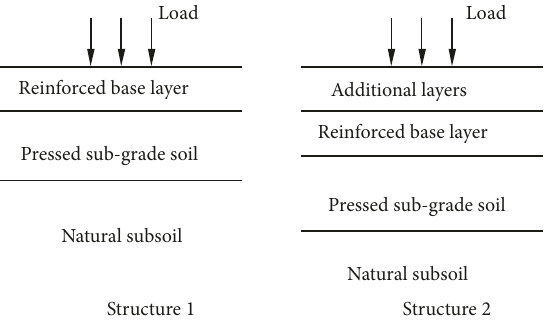
Figure 1: Illustrations of typical structures of soil pavement run-